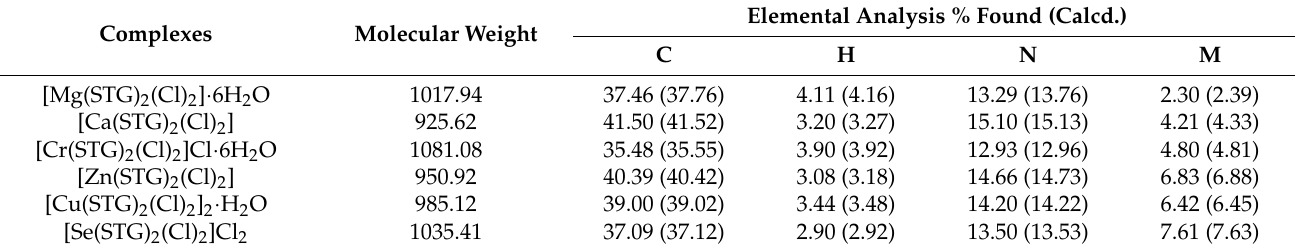
Table 1. Analytical data of the STG complexes.